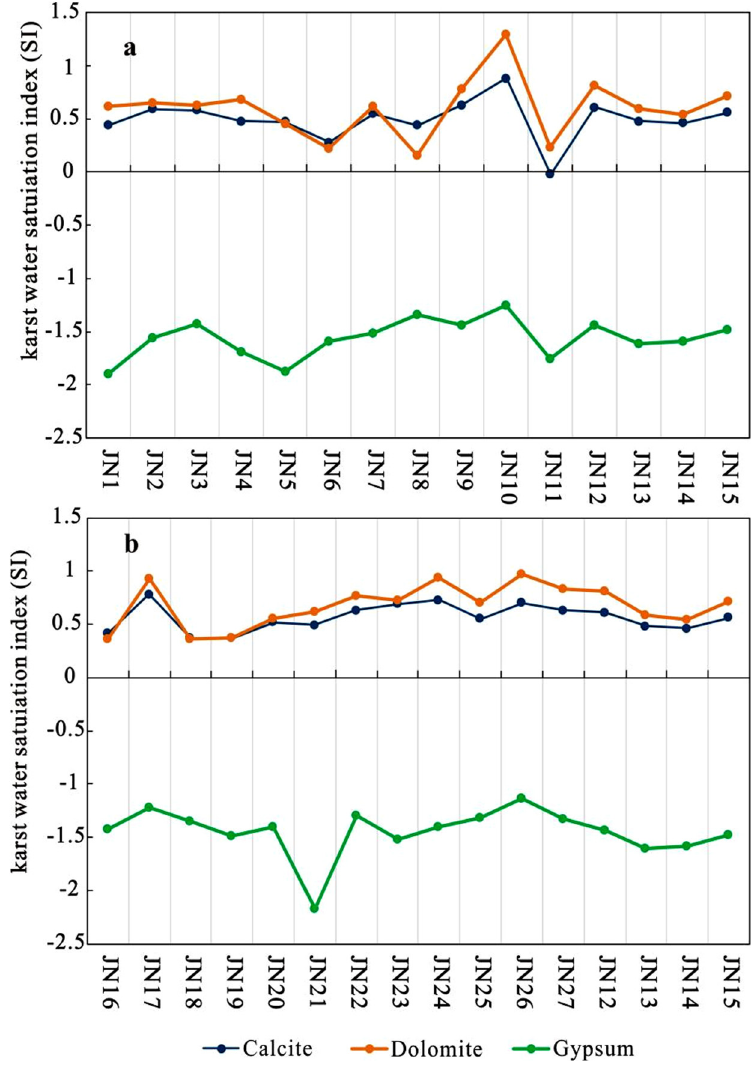
Figure 9. The mineral saturation index of calcite, dolomite, and gypsum in the karst aquifers along Flow Paths I and II. ( a ) Flow Path I (the south–north flow path), from the south recharge area to the discharge area; ( b ) Flow Path II (the west–north flow path), from the leakage area (Yufu river) to the discharge area.